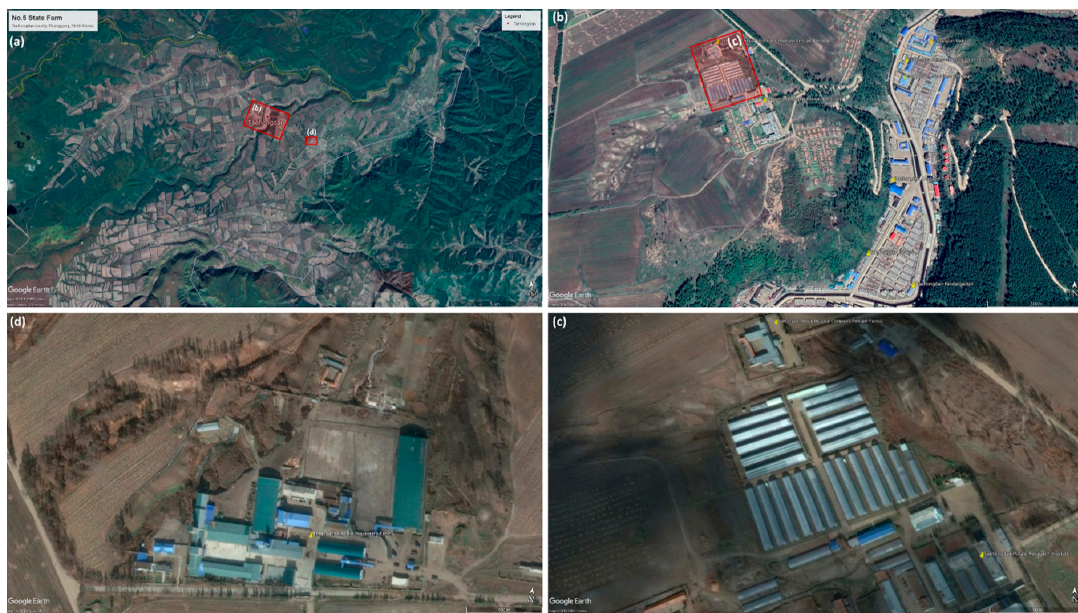
Figure 4. Spatial characteristics of State farmlands extracted from high-resolution EO data; ( a ) describes whole region of the No. 5 State farmland in Taehongdan county in Ryanggang; ( b ) shows key spatial arrangements of State farmlands embracing: agriculture-based infrastructures (e.g., fertilizer and processing factories and colleges and research institutes etc.); monumental buildings (e.g.,